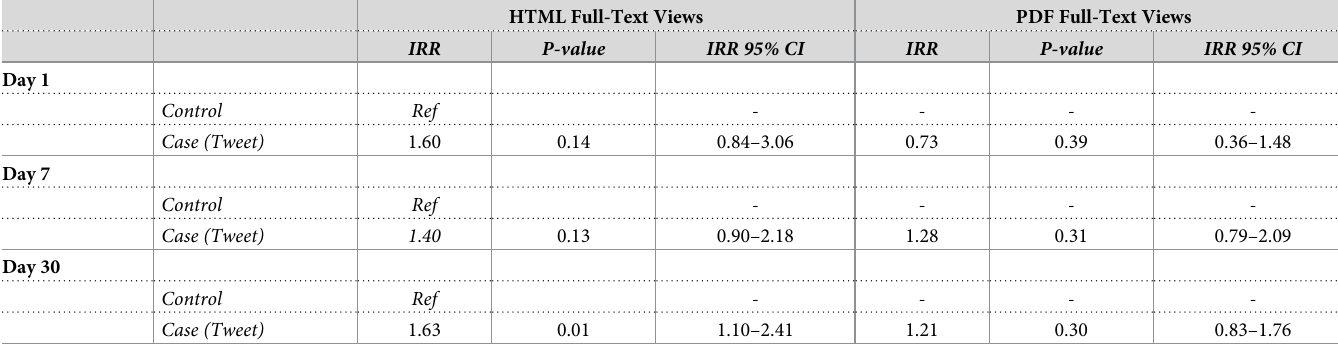
Table 2. Negative Binomial Regression Model Results Stratified by Page-View Metrics, Time Period, and Condition for a 2018 Study of the Effects of Journal Tweet- ing on article page